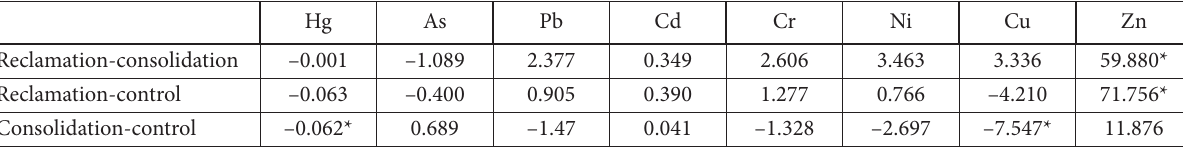
Table 6. Significance tests for soil heavy metal concentrations associated with soil reclamation areas Hg